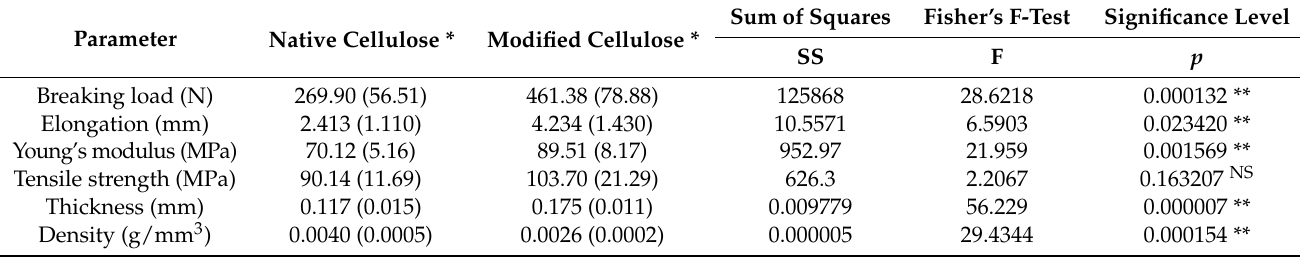
Sum of Squares Fisher’s F-Test Significance Level